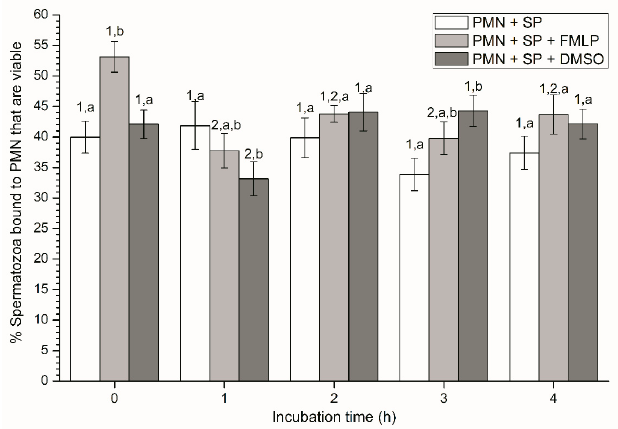
Figure 1. Percentages of viable spermatozoa bound to PMN in the three treatments (PMN + SP, PMN + SP + FMLP and PMN + SP + DMSO) throughout the incubation time (4 h; Experiment 2). Different superscripts ( a, b ) mean significant ( p < 0.05) differences between treatments within a given time point, and different numbers ( 1, 2 ) mean significant ( p < 0.05) differences between incubation times within a given treatment. Data are shown as mean ± SEM for seven experiments. Sperm concentration: 500 × 10 6 sperm/mL. PMN concentration: 100 × 10 6 PMN/mL. PMN: polymorphonuclear neutrophils; SP: